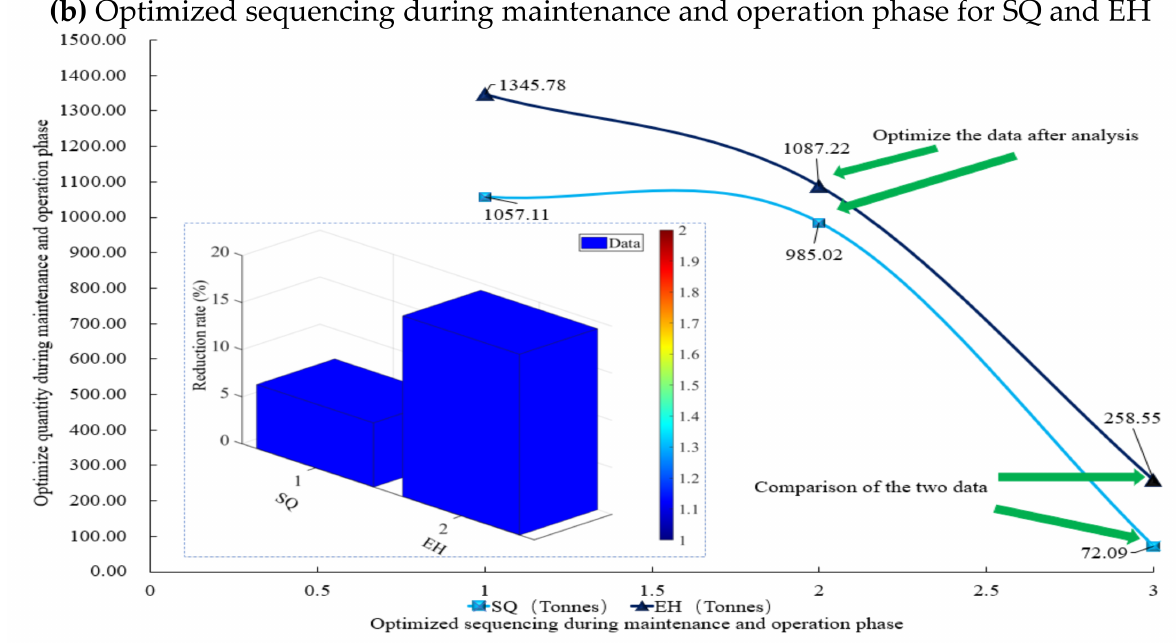
Figure 17. Five-stage contribution of transportation vehicles and operation and maintenance vehicle assessment chart for SQ and